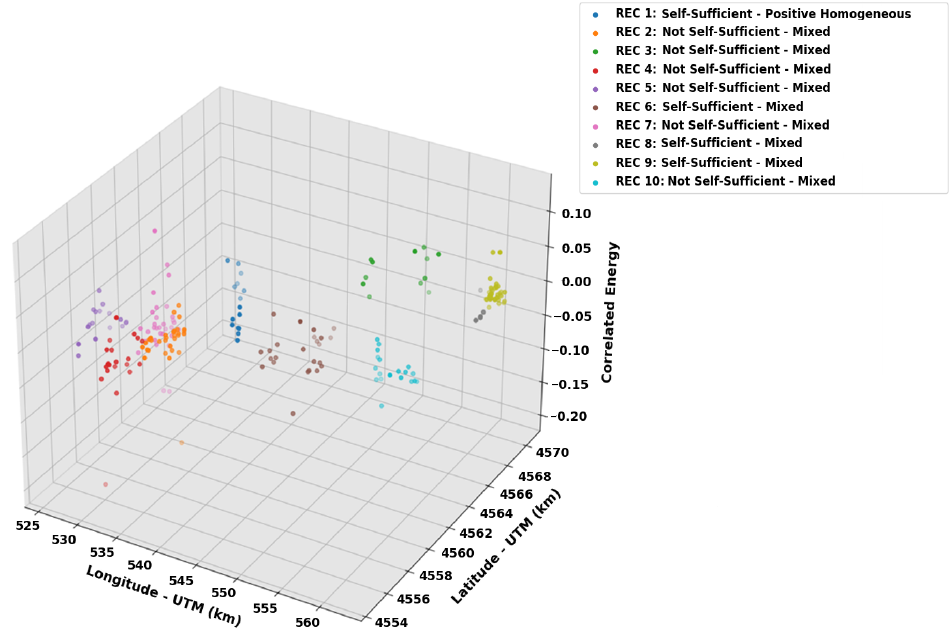
Figure 14. Members distributed by REC (real REC not identified) — K-means.